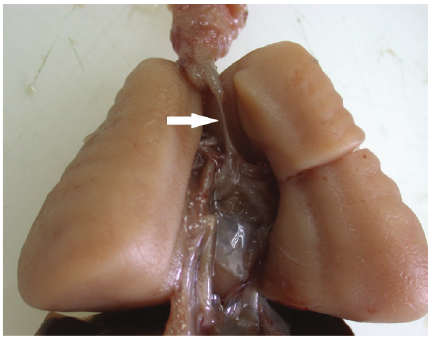
Figure 3: Postmortem autopsy findings of case 1 compatible with tracheal atresia (arrow): voluminous lungs and dilated upper airways.